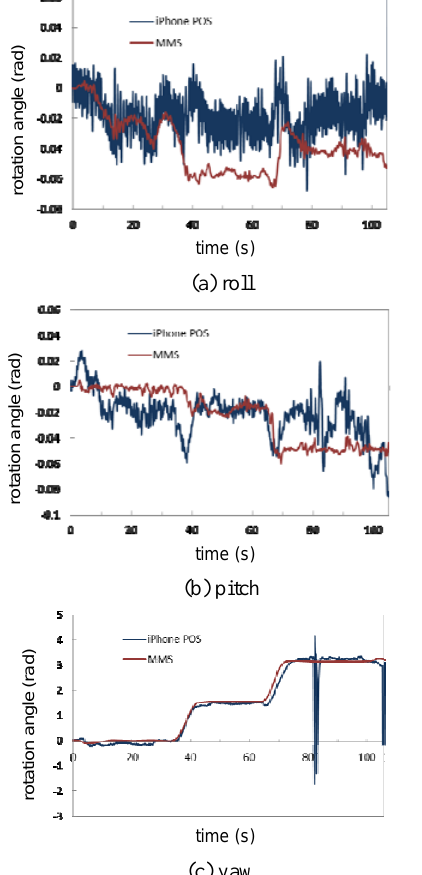
Figure 7. Results of rotation angle with POS sensor fusion The displacement between estimated value and MMS data with respect to roll, pitch, and yaw is 0.024 (rad), 0.031 (rad), and 0.17 (rad) on average, respectively. In the result of yaw, the gap was large, because of limitation of function in iPhone, that is negative value of yaw angle is converted to zero automatically.